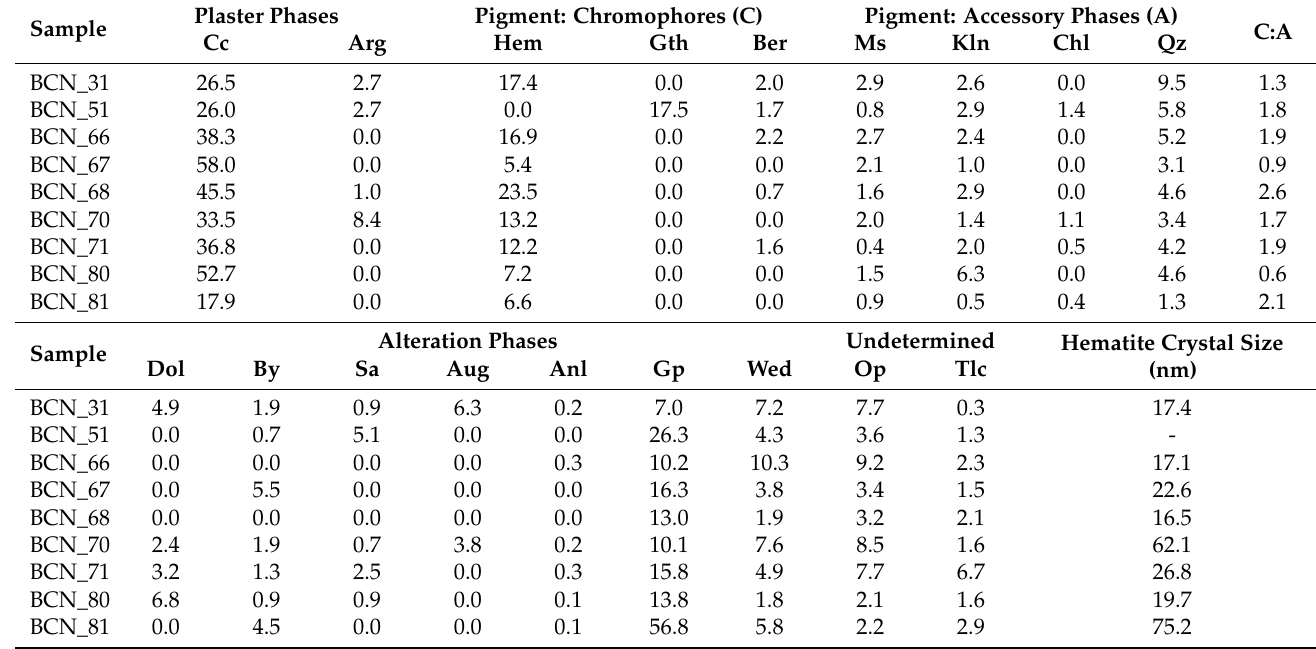
Alteration Phases Undetermined Hematite Crystal Sample